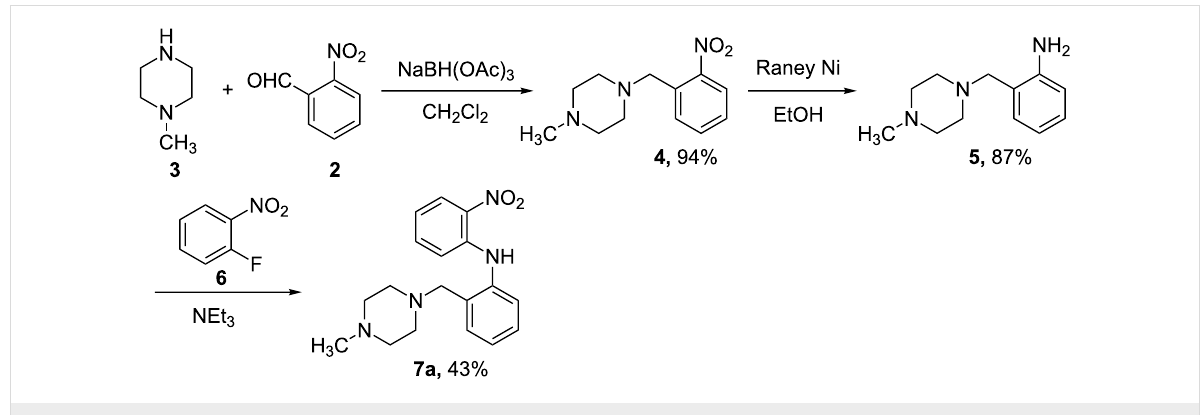
Scheme 1: Synthesis of anilino nitrobenzene 7a .